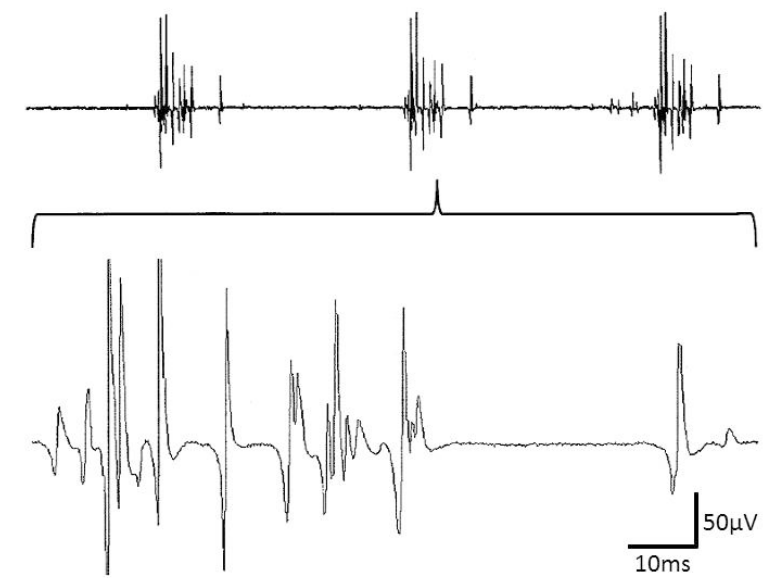
Figure 1. Complex repetitive discharges (CRD) with multiple spike components and a very large potential-free interval as part of the CRD cycle. Note that part of the spikes saturates.